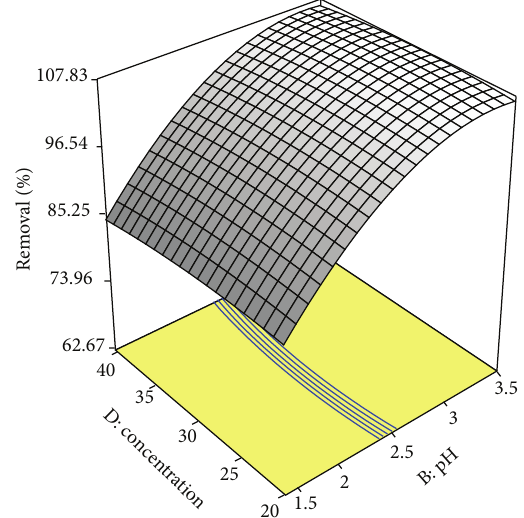
Figure 5: Response surface plot showing the effect of pH and concentration of lead and their mutual effect on the removal of lead using tartrate-Mg-Al layered double